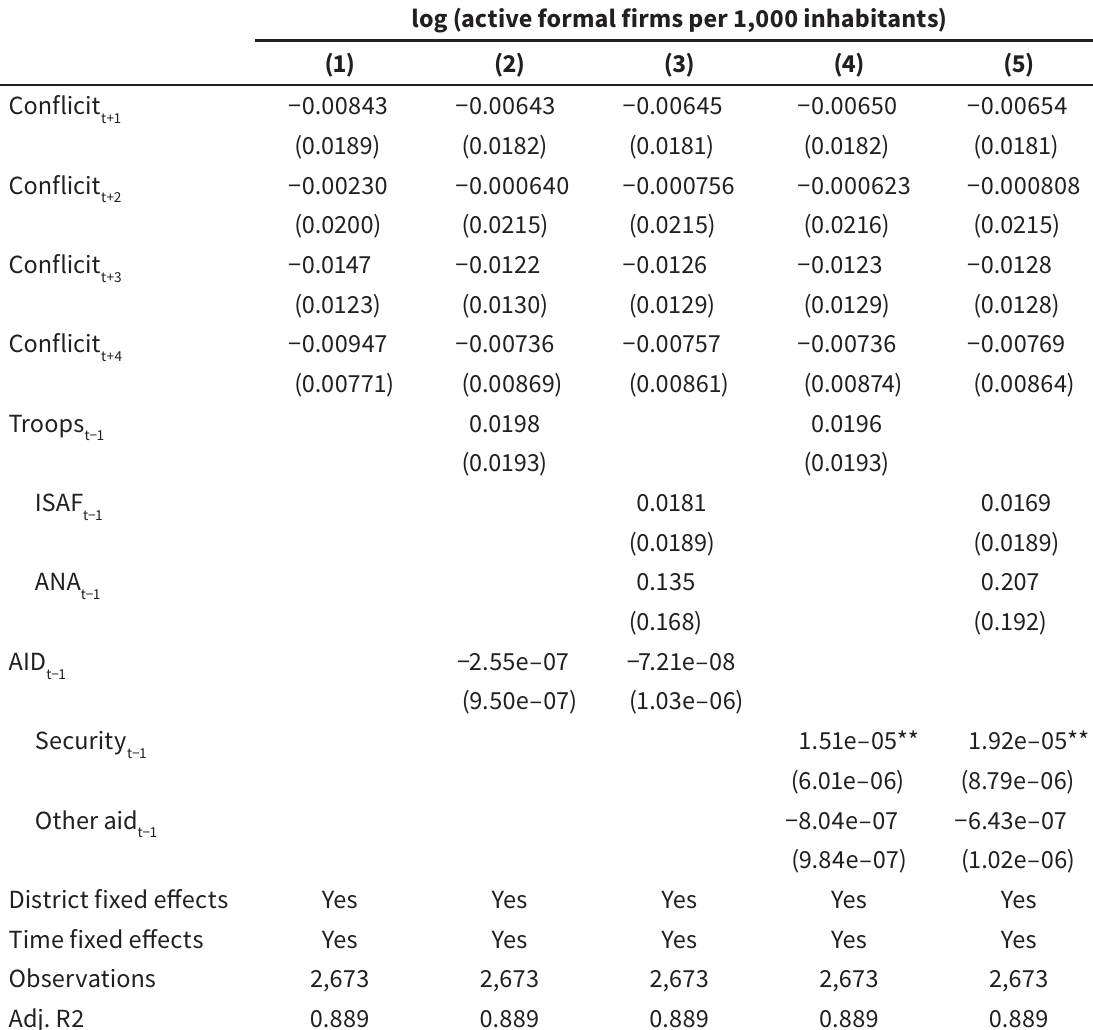
Conflict and active formal firms (placebo